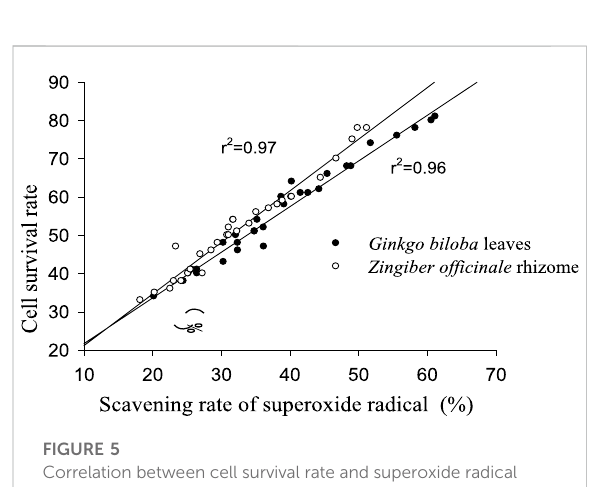
FIGURE 5 Correlation between cell survival rate and superoxide radical scavenging rate under treatment by the two plant